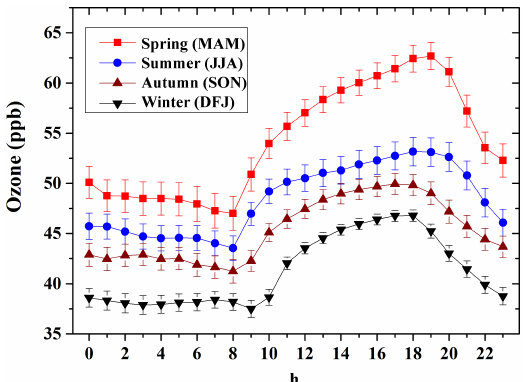
Figure 3. Diurnal profiles of average hourly surface ozone at Nam Co Station by seasons. Error bars show the 95% confidence inter-